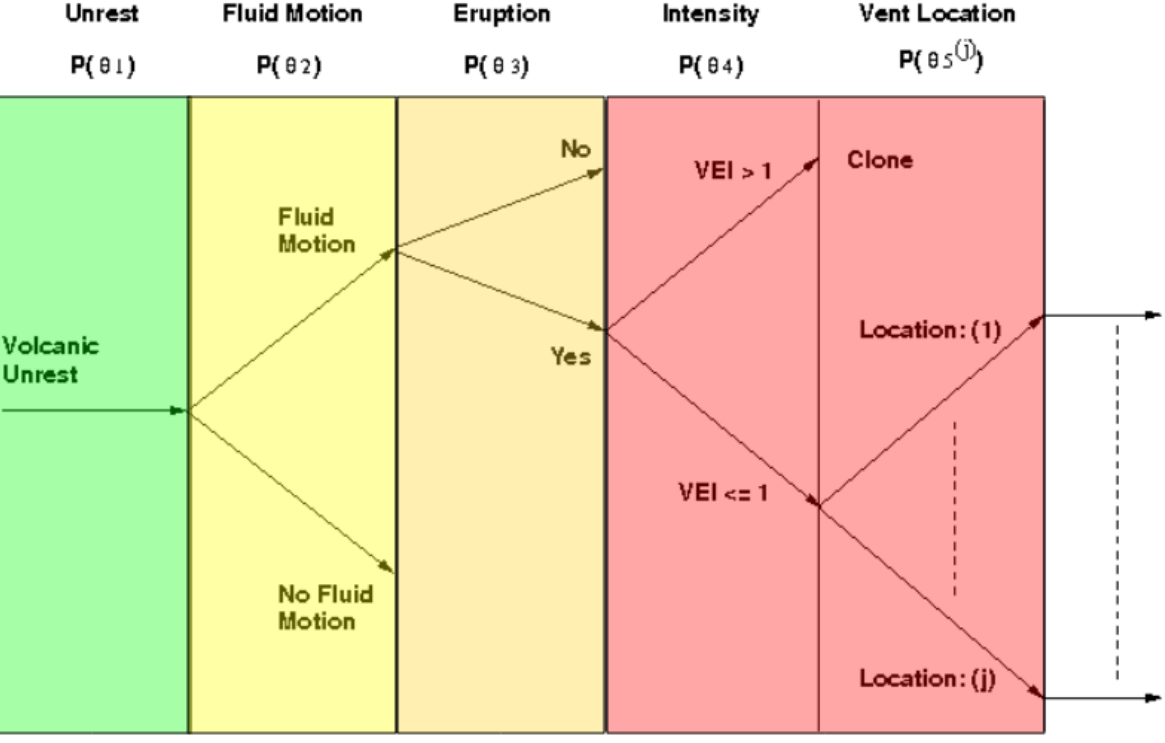
Figure 1. Schematic representation of the event tree, where the clone label indicates the tree structure at that point is identical to that below. The color code represents the USGS ground-based hazard declarations and are superimposed over their respective event tree